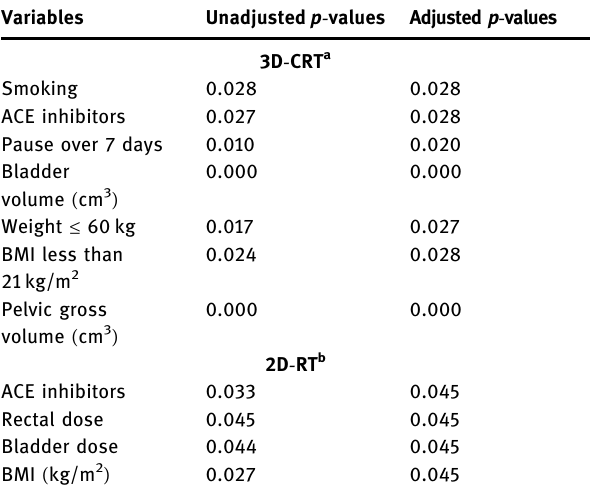
Table 3: Benjamini – Hochberg correction for adjusted p -